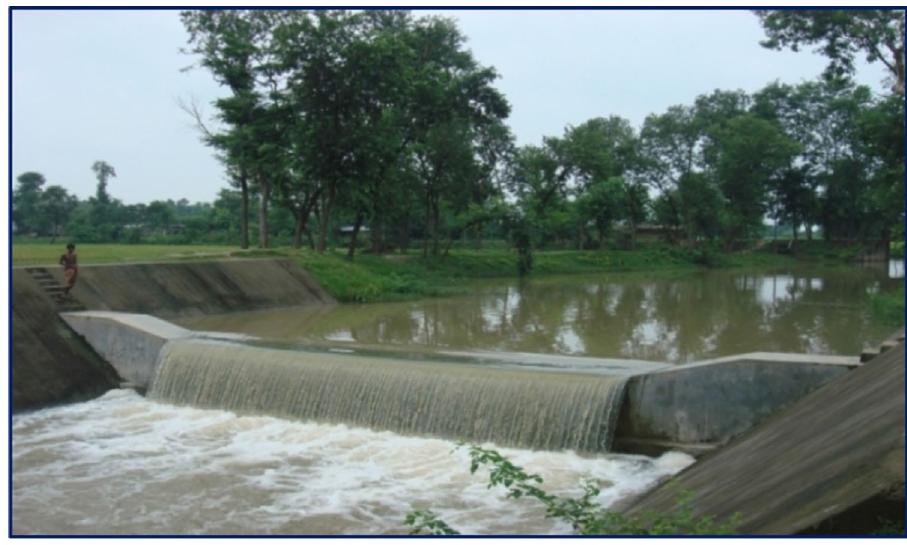
Fig. 2 The re-excavated Shar- maongla Khari with a cross dam under Godagari